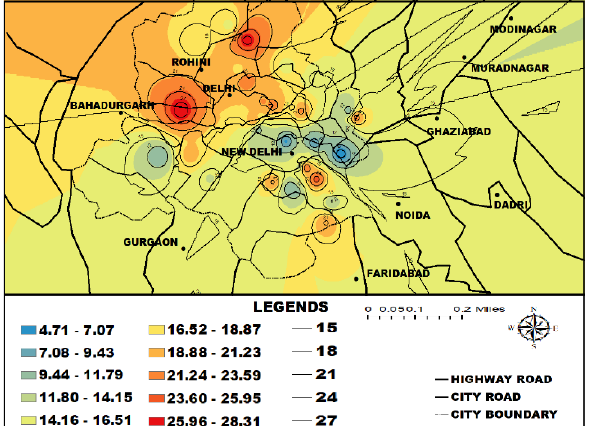
Figure 6. Air quality map of Delhi May monthly average based on SOx (µg/m 3